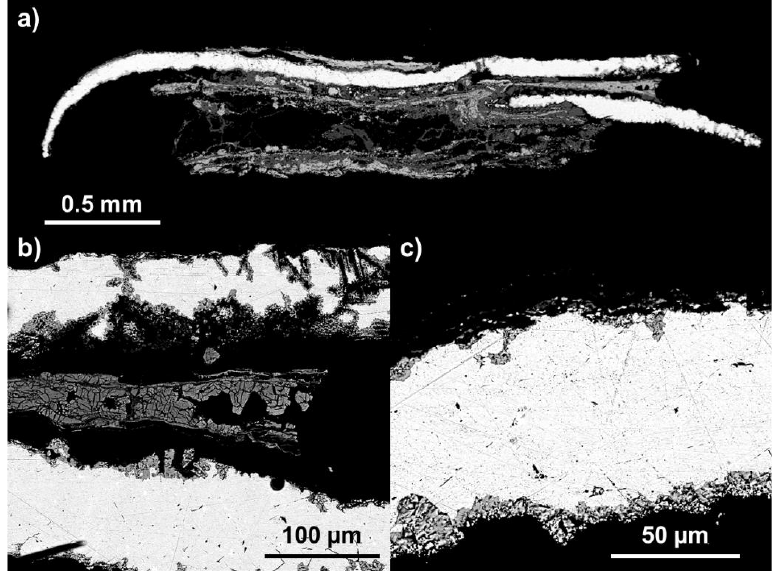
Figure 5. SEM images (BSE detector) of a cross-section from a sample collected from the bell of a brass trumpet, showing the full stratigraphy ( a ), the corrosion layer (dark grey) developed between the brass sheets (light grey) ( b ) and the corroded brass sheet ( c ).